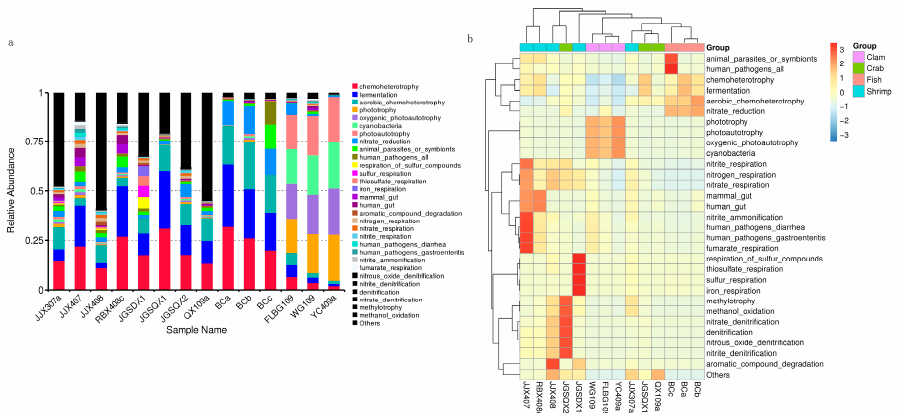
Figure 4. Microbial functional predictions using FAPROTAX between samples ( a ) and groups ( b ), based on the relative abundance of bacterial taxa.